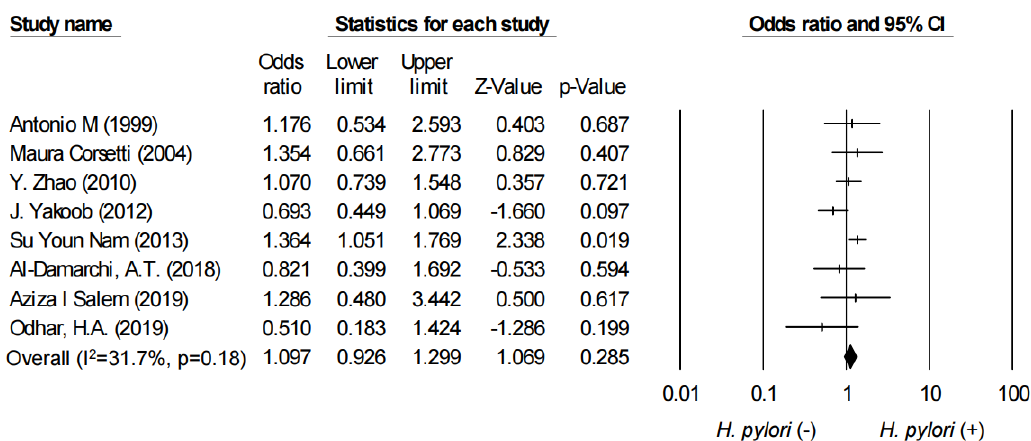
Figure 3. Forest plot evaluating the combined OR between IBS and according to Rome criteria and H. pylori